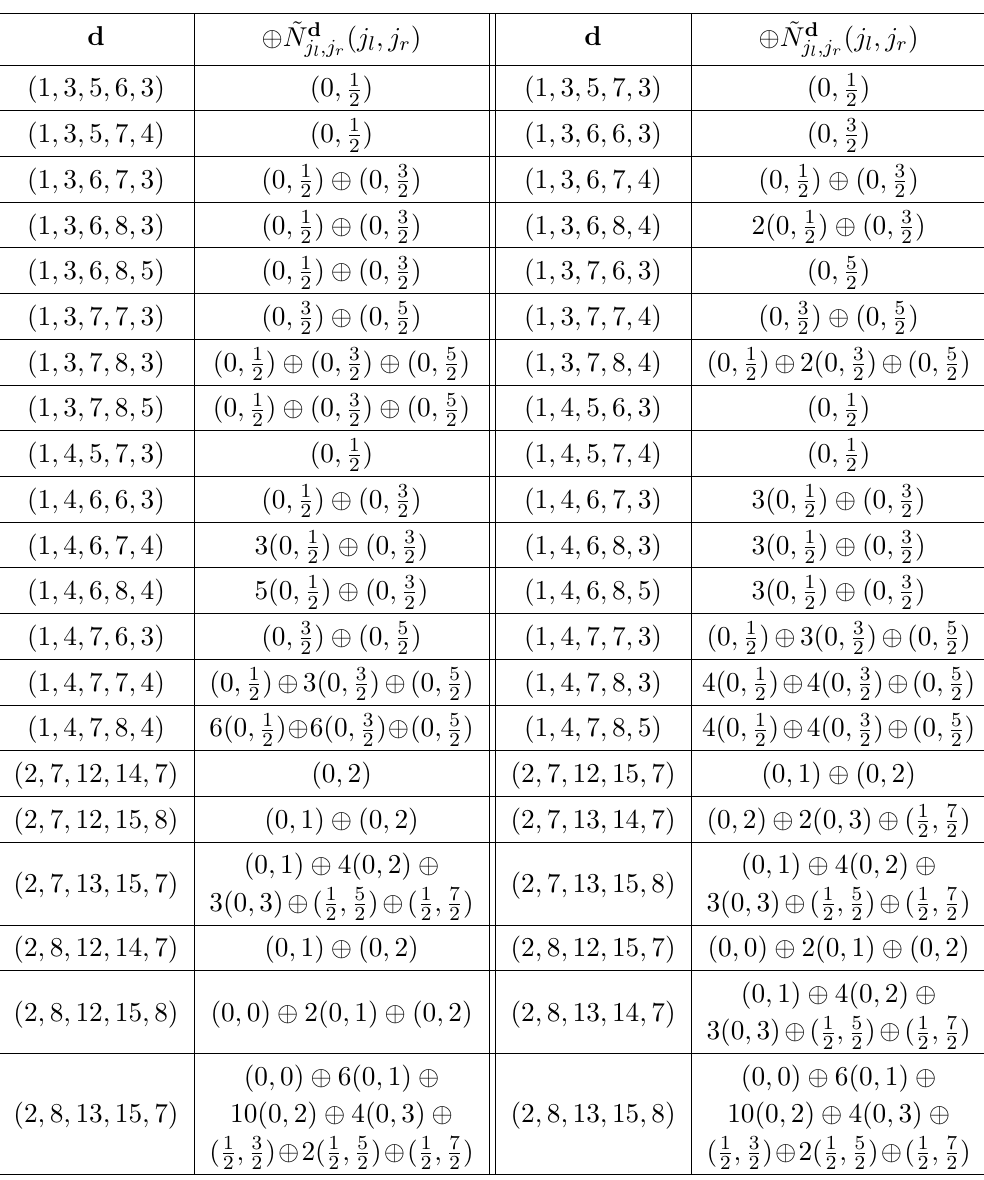
Spectrum of the fundamental Wilson loop in the F 4 gauge theory for d 1 = 1 , ( d 2 , d 3 , d 4 , d 5 ) ≤ (4 , 7 , 8 , 5) and d 1 = 2 , ( d 2 , d 3 , d 4 , d 5 ) ≤ (8 , 13 , 15 , 8) . Here, d = ( d 1 , d 2 , d 3 , d 4 , d 5